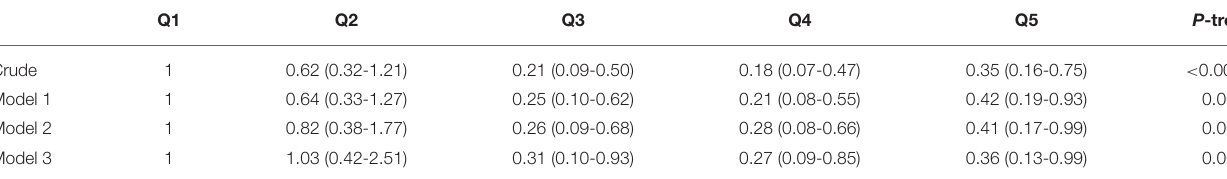
TABLE 5 | Multivariable-adjusted odds ratios for COPD across quintiles of LCD